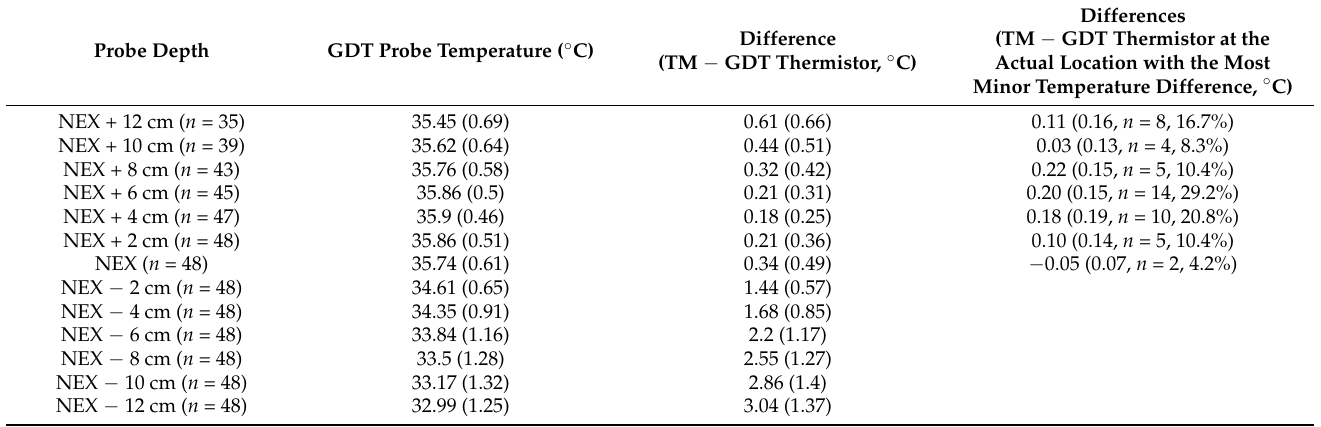
Table 2. Mean (SD) of GDT probe temperature and differences in temperatures between the tympanic membrane and GDT thermistor according to insertion depths of